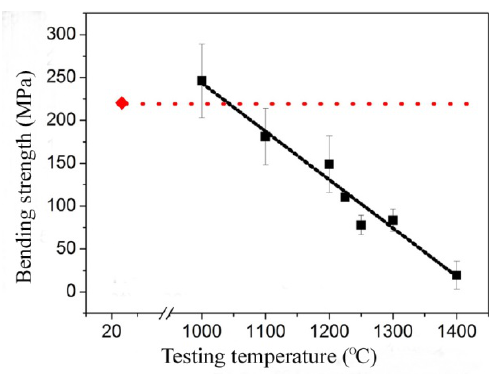
Fig. 10 4-Point bending strength of CVD-SiC/CVD-SiC joint fabricated by SPS joining using pre-sintered Ti 3 SiC 2 foil as interlayer at room temperature and high temperatures. Reproduced with permission from Ref. [111], © Elsevier Ltd. 2016.